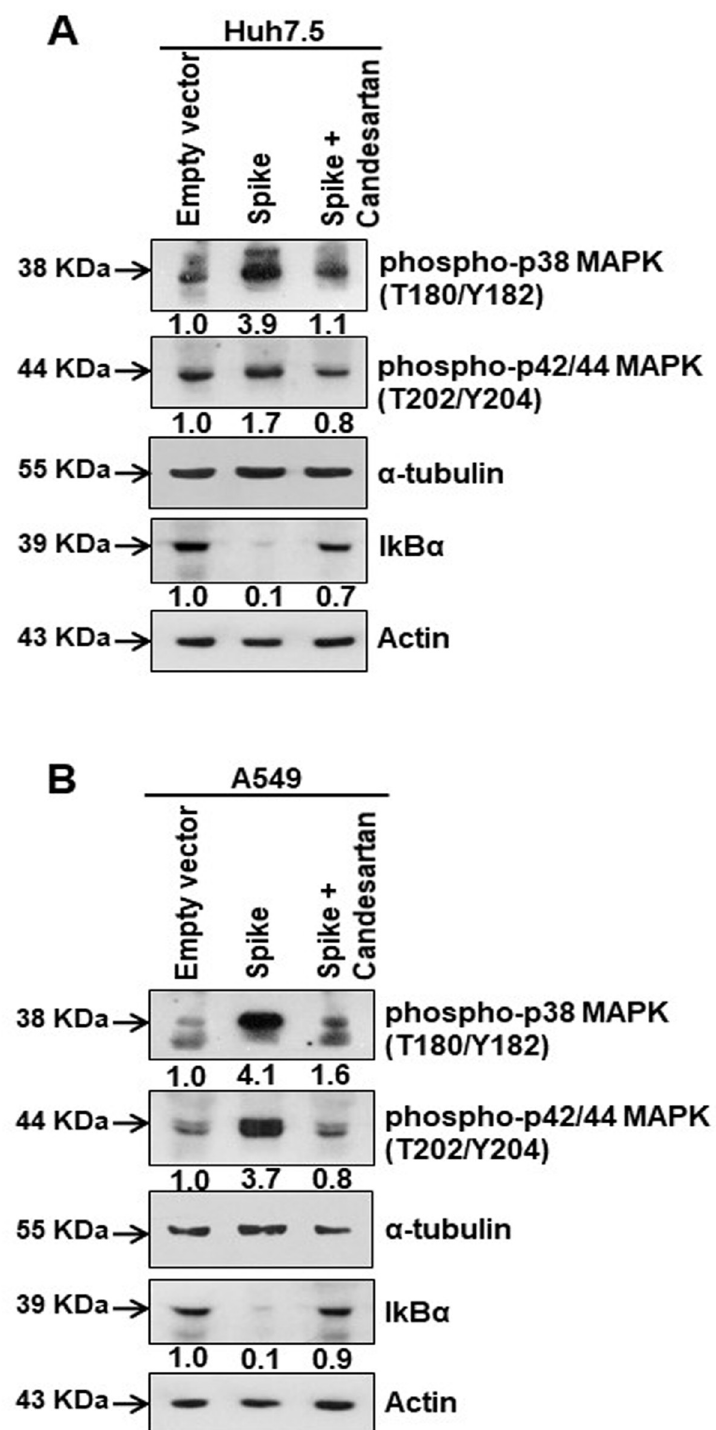
Fig 3. Candesartan cilexetil as an AT1 receptor antagonist prevent MAPK activation. (A) Western blot analysis of phospho-p38 MAPK (Thr180/Tyr182) and phospho-p42/44 MAPK (Thr202/Tyr204) in Huh7.5 cell lysates prepared after 48 h of transfection of SARS-CoV-2 spike gene construct with or without Candesartan cilexetil treatment. Expression level of actin in each lane is shown as a total protein loading control for comparison. (B) Western blot analysis of phospho-p38 MAPK (Thr180/Tyr182) and phospho-p42/44 MAPK (Thr202/Tyr204) in A549 cell lysates prepared after 48 h of transfection of SARS-CoV-2 spike gene construct with or without Candesartan cilexetil